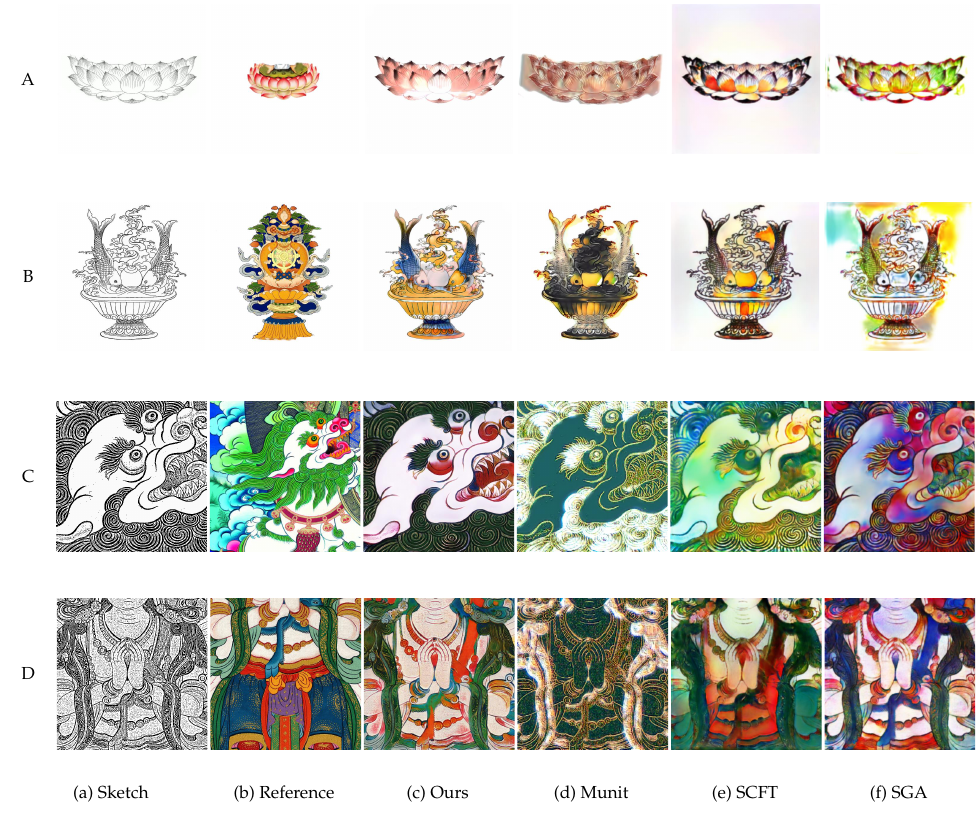
Figure 5. Colorization result of Thangka sketch. Compared with Munit [20] ( d ), SCFT [2] ( e ), and SGA [3] ( f ), our results ( c ) show correct correspondence between the sketch and the reference images. Munit [20] ( d ) does not learn semantic information correctly, SCFT [2] ( e ) shows significant artifacts, and SGA [3] ( f ) shows significant color misalignment. Column ( a ) is the sketch of the Thangka, and column ( b ) is the reference image. A,B show the results of the Danbooru 2019 dataset, and C,D compare the results of the Thangka